Question: Identify the chart type used in this figure.
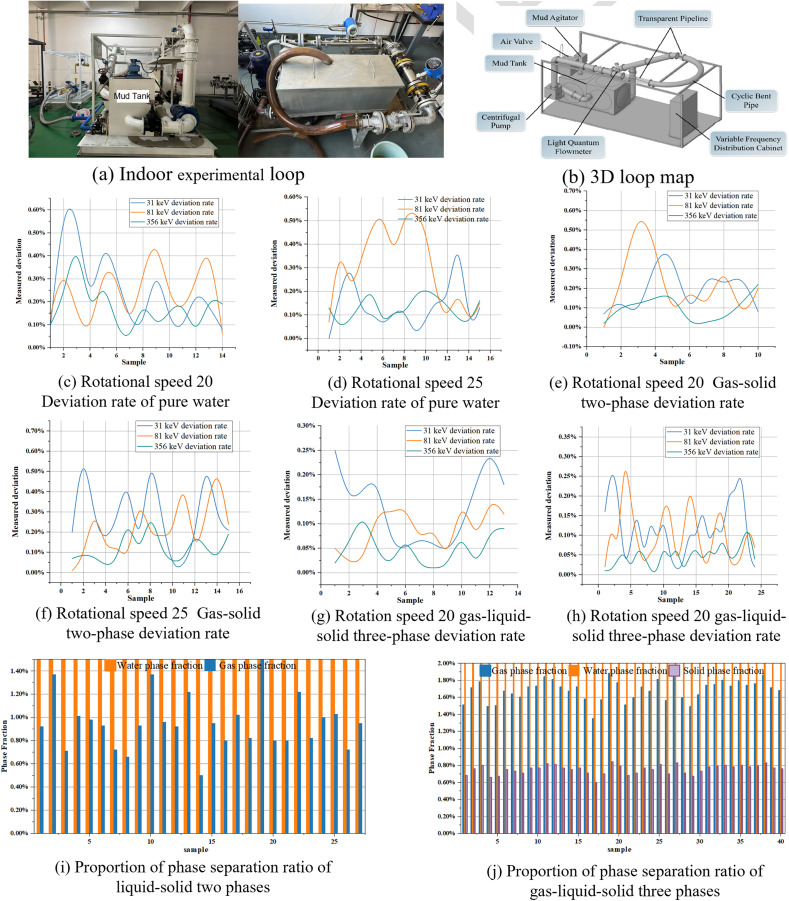
Answer: bar